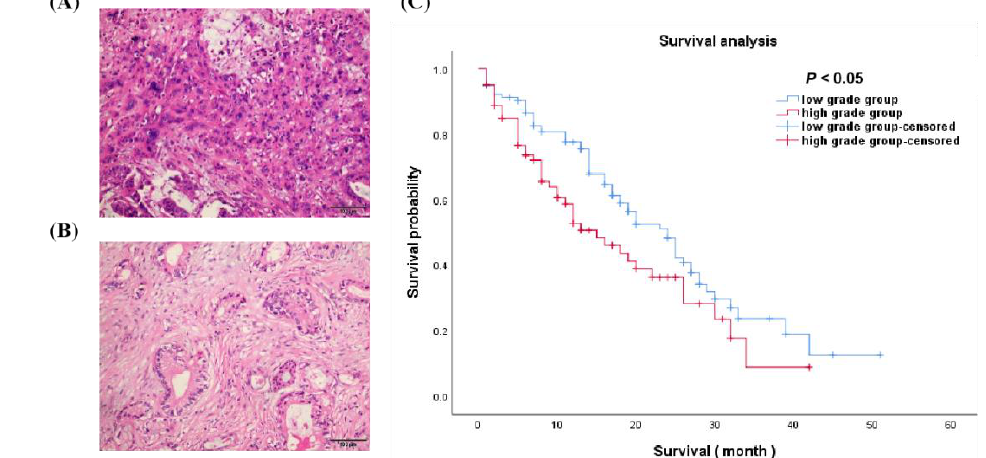
Figure 3. A comparison between patients within the low-grade and the high-grade group. ( A ) High-grade group pathological expression (×20). ( B ) Low-grade group pathological expression (×20). ( C ) The Kaplan–Meier curves of the two groups were significantly different ( p < 0.05). Patients in the low-grade group had significantly longer survival than those in the high-grade group by log-rank test.